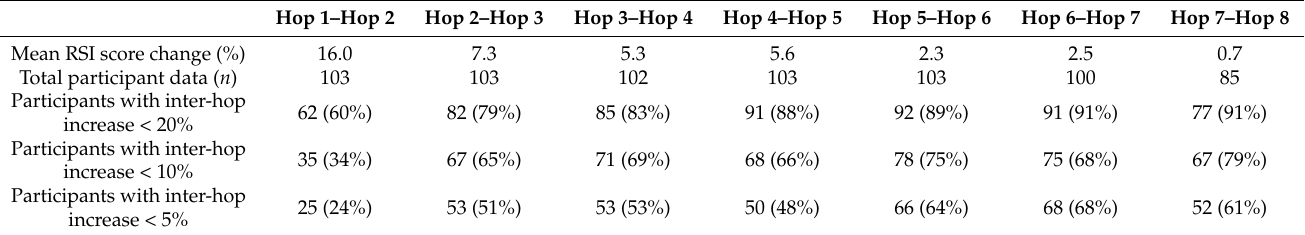
Table 1. The proportions of participants with stable hop-RSI scores across consecutive